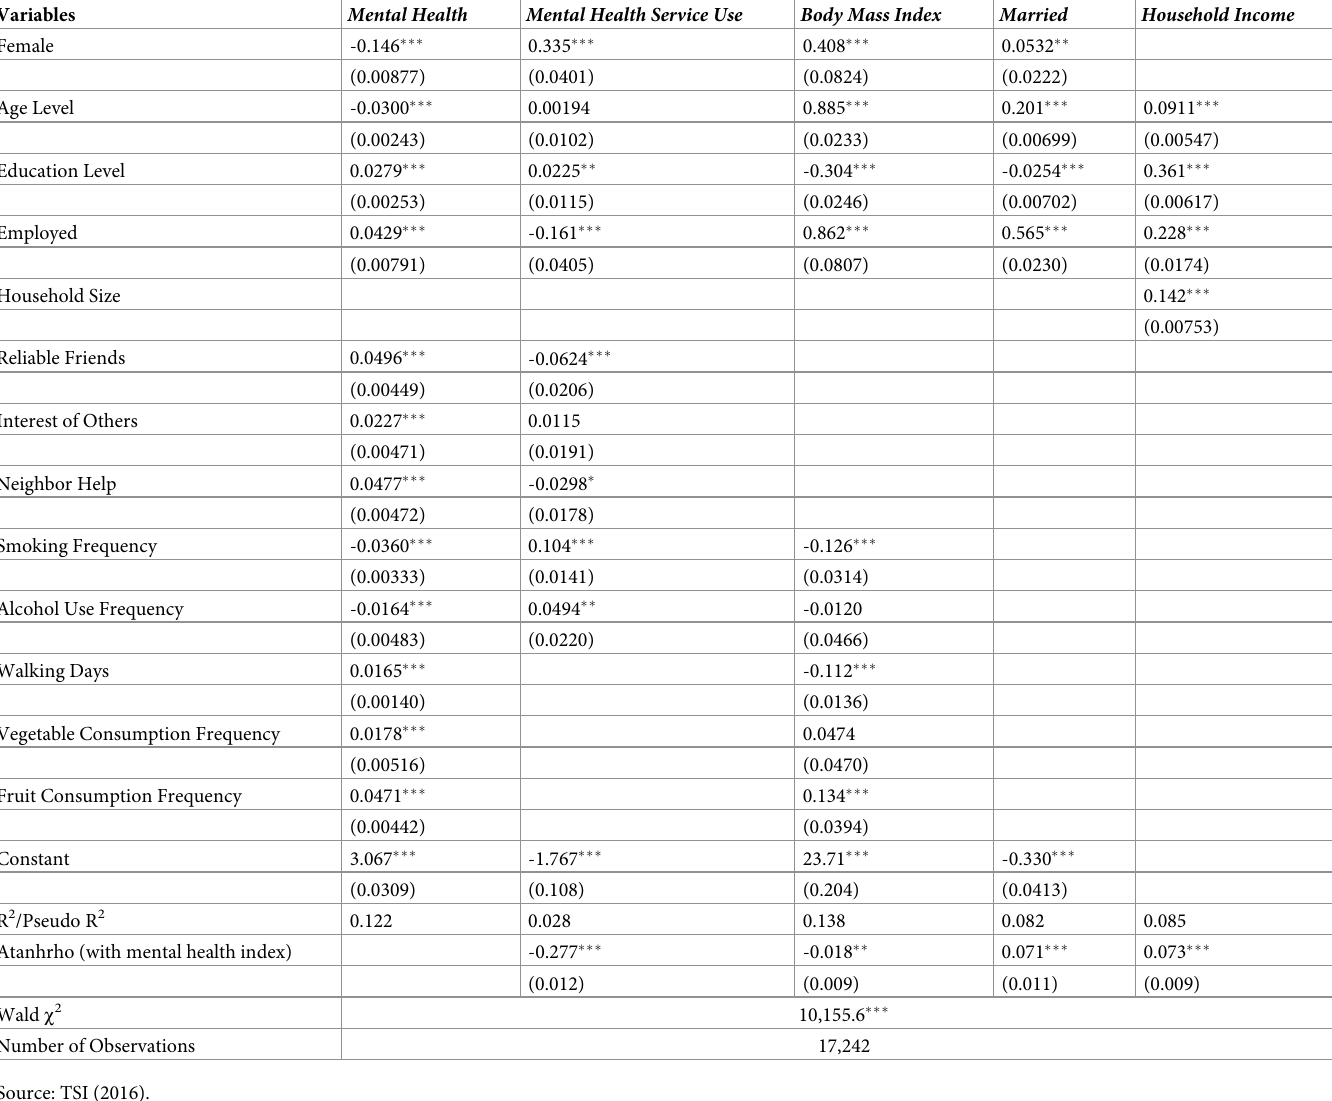
Table 4. CMP estimation results for mental health and income: Full